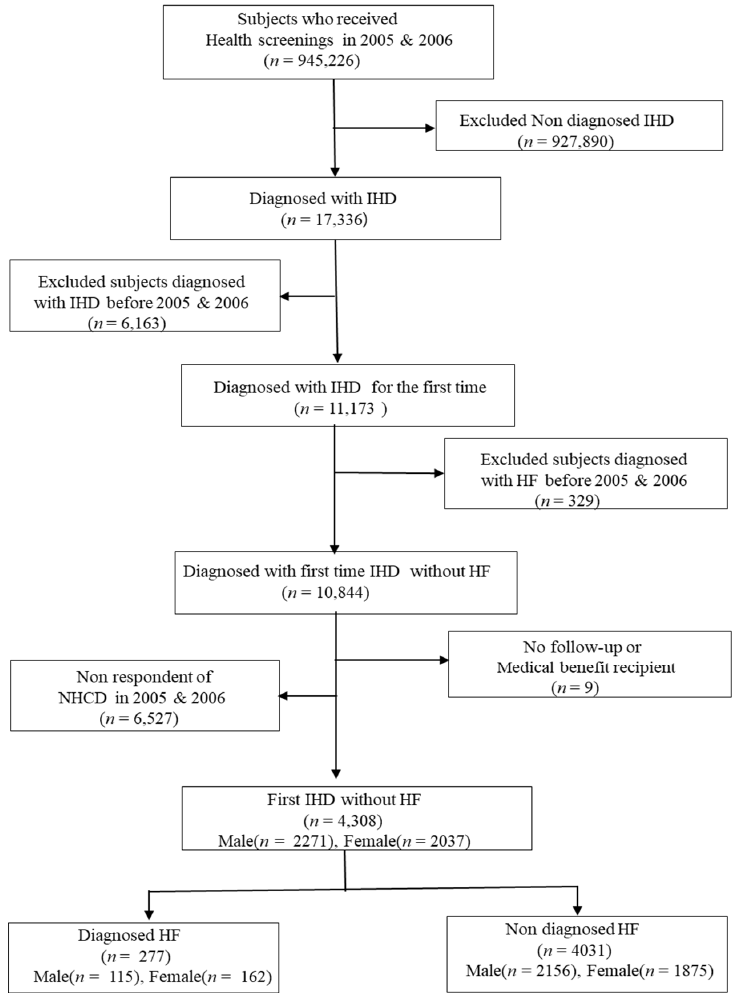
Figure 1. Flow chart of the study population. IHD: ischemic heart disease, NHCD: national health check-up data, HF: heart failure.